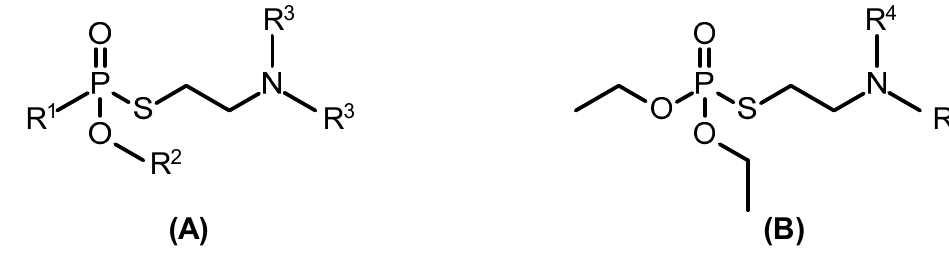
Figure1. Genericchemicalstructureoforganophosphonothioates( A )andorganophosphorothioates( B ). Figure 1. Generic chemical structure of organophosphonothioates ( A ) and organophosphorothioates ( B ).